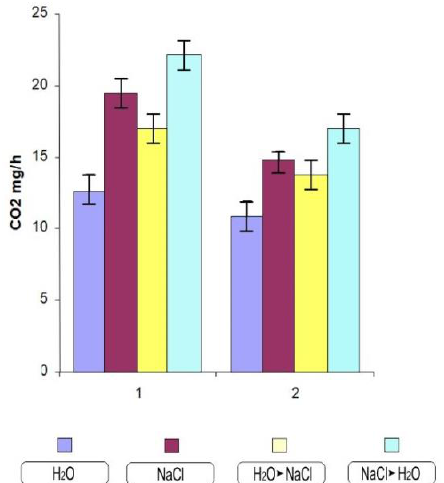
Figure 5. The respiration intensity of 10-day-old wheat varieties. 1—Orenburgskaya 10; 2— Orenburgskaya 22. The mean values and their standard deviations are shown according to Student's criterion, p < 0.05.